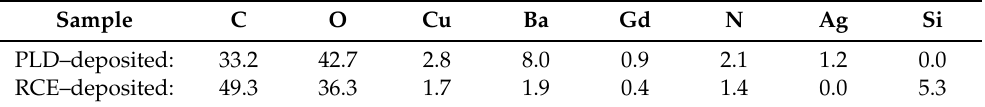
Table 2. Atomic concentrations in % of elements detected on the surface of as–received PLD–deposited and RCE–deposited samples by the XPS method. Analysis depth in the ∼ nm